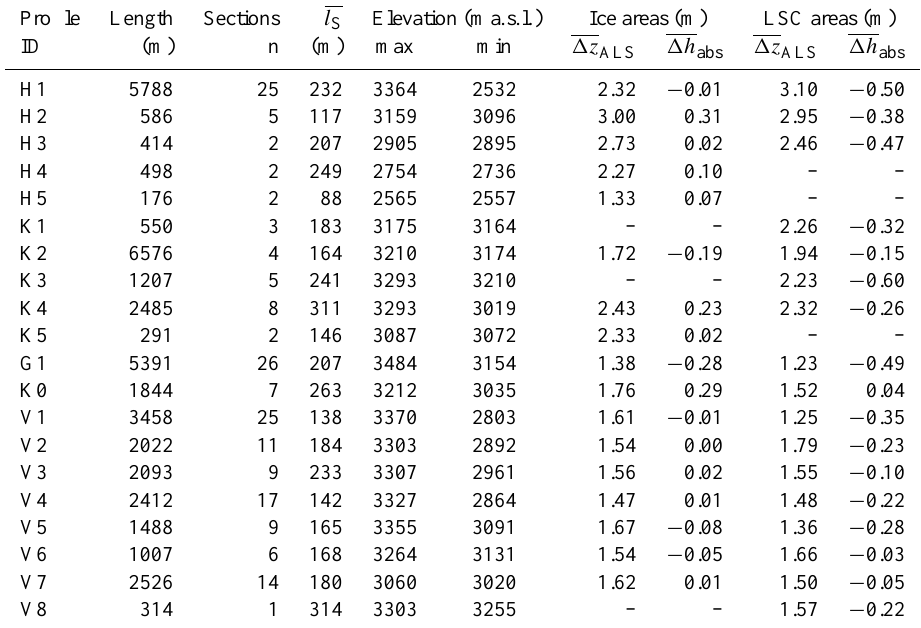
Table 3. Properties of the GPR profiles in terms of ID, profile length, number of sections, the mean section length ( l S ), minimum elevation and maximum elevation. Mean value of the surface elevation changes derived from ALS data 1z ALS (Eq. 1) and the mean absolute difference of this value from mean GPR snow depth 1h abs (Eq. 11) are shown for LSC areas and ice areas of each